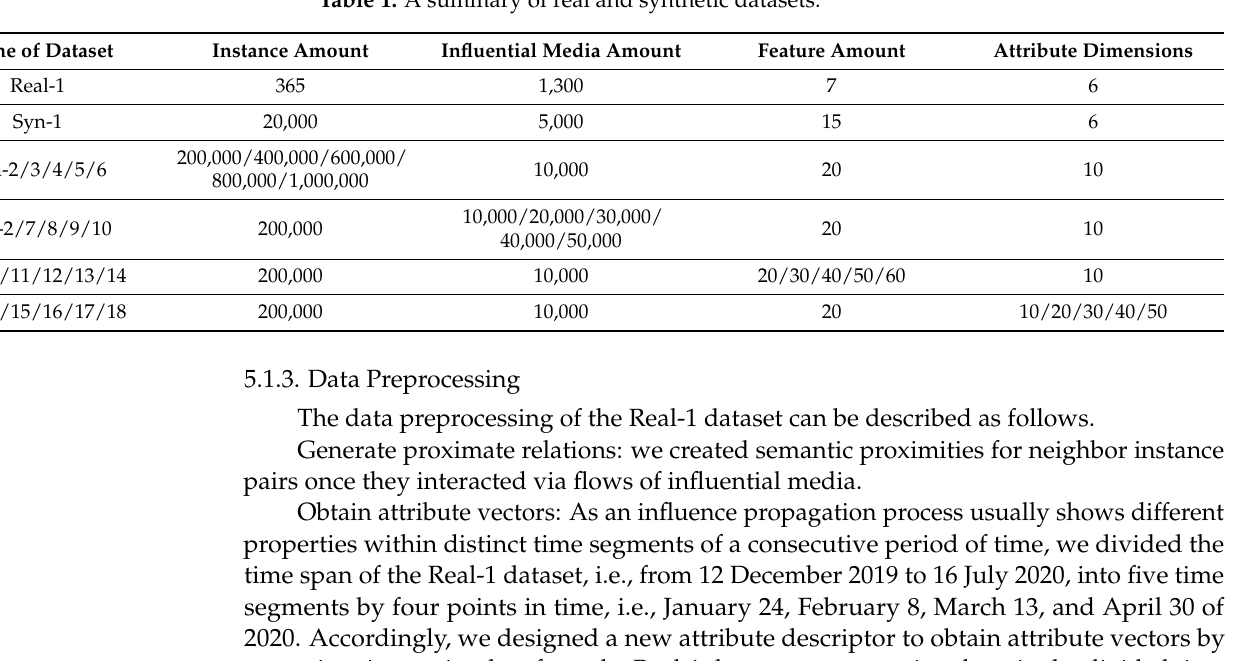
Table 1. A summary of real and synthetic